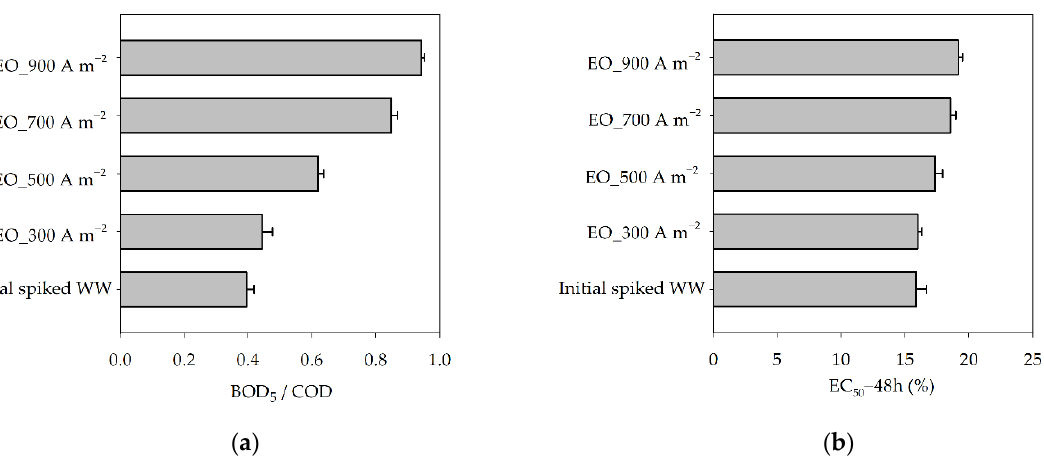
Figure 5. ( a ) Biodegradability index given by ratio BOD 5 /COD; ( b ) ecotoxicity towards D. magna expressed in terms of EC 50 – 48 h (%) for initial WW sample spiked with recalcitrant compounds utilized in the EO experiments, and for final samples obtained after 6 h of EO treatment at different studied applied current densities.